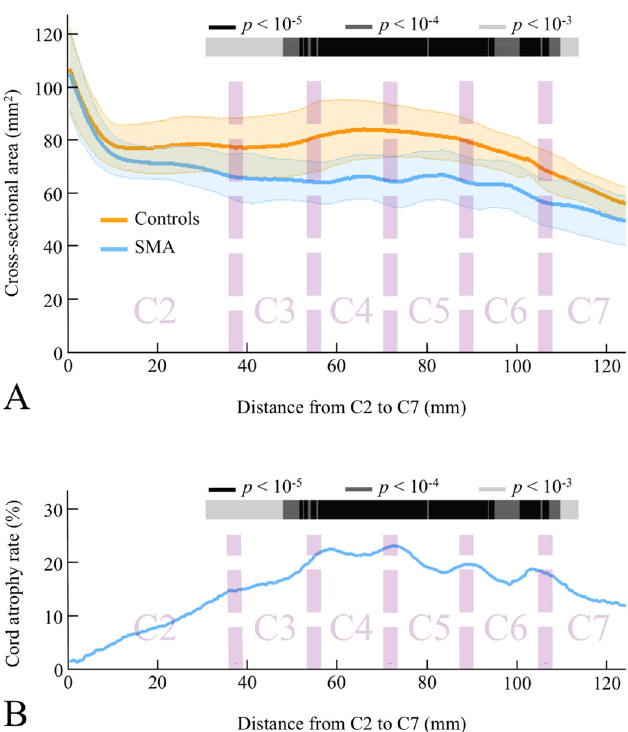
Fig 3. 2D atrophy profile along the cervical spinal cord in SMA patients. (A) Cross-sectional area profile in SMA patients and controls. (B) Cord atrophy rate in SMA patients. The color-coding indicates regions with significant atrophy (color scale = p-values of the between groups